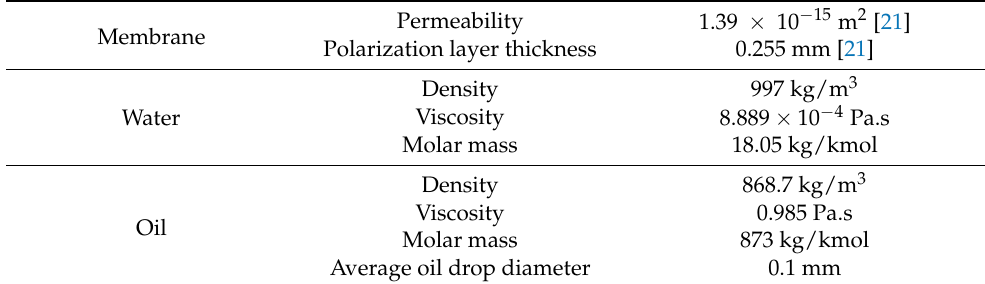
Table 2. Physical, chemical, and geometrical parameters of the membrane and fluids phases (T = 293.15 K).